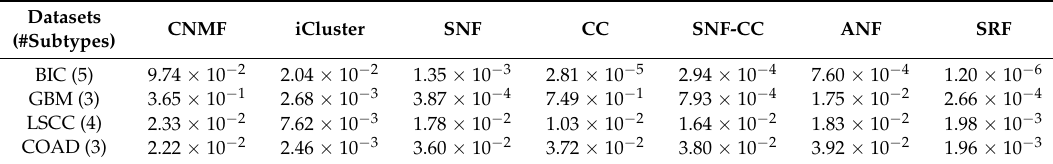
Table 3. Comparison with six existing integrative methods.